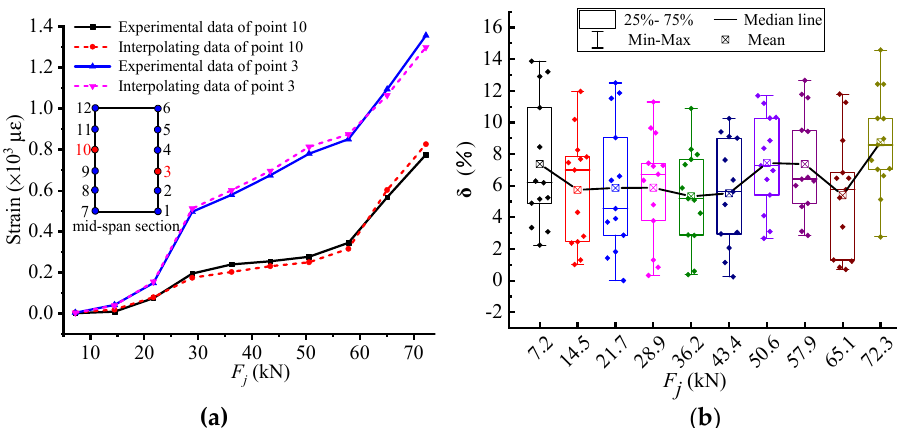
Figure 11. Strain data error results of the HG-1-12 specimen midspan section. ( a ) Comparison curve for points 3 and 10 on the midspan section. ( b ) Error of cross-checking of all measuring points.